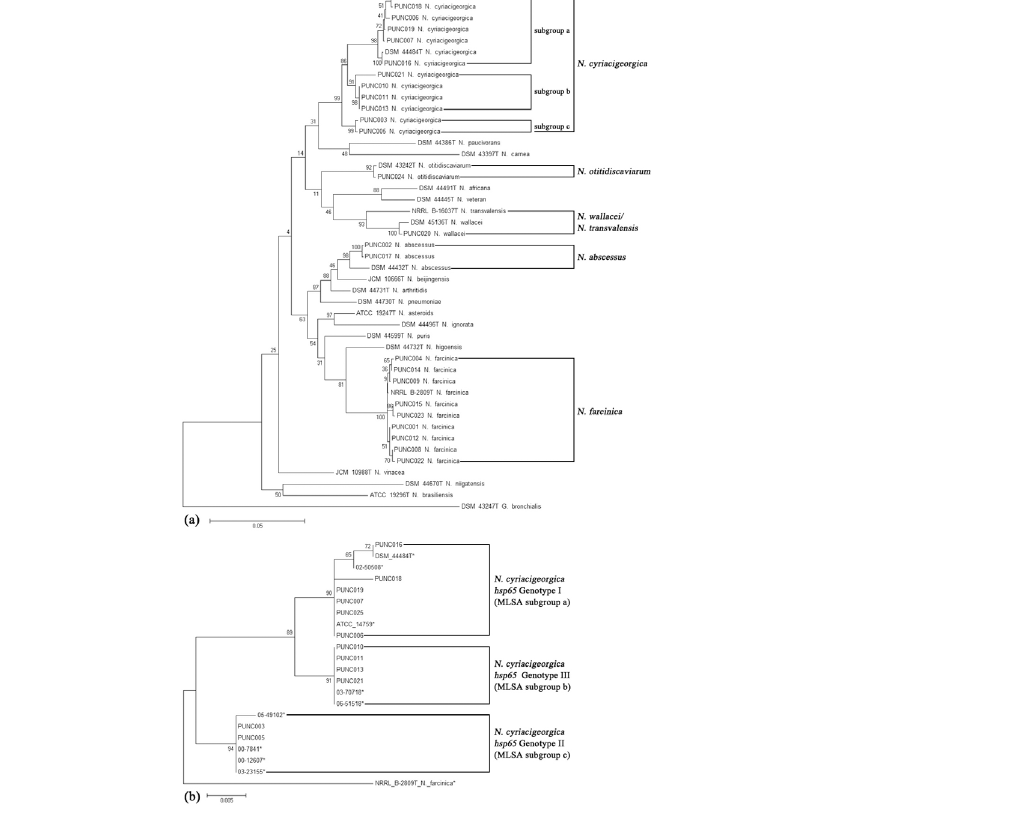
Fig 1. Phylogenetic trees are shown and were conducted using the maximum-likelihood method. Fig 1a. Phylogenetic tree based on the concatenated gyrB -16S- secA1 - hsp65 - rpoB sequences of 25 Nocardia clinical isolates and 20 Nocardia type strains, using Gordonia bronchialis strain ATCC 25592 T as an outgroup (S1 Table). Fig 1b. Phylogenetic tree based on the hsp65 gene sequences of 12 N . cyriacigeorgica clinical isolates and nine Nocardia cyriacigeorgica isolates whose genotypes have previously been determined by Schlaberg et al . [29] using the sequence of a Nocardia farcinica strain as an